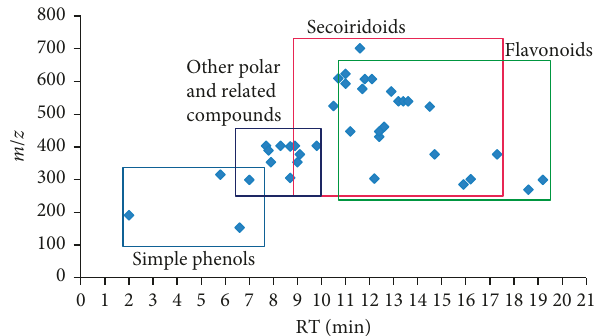
Figure 2: Distribution of the identified compounds according to their retention time and m/z .